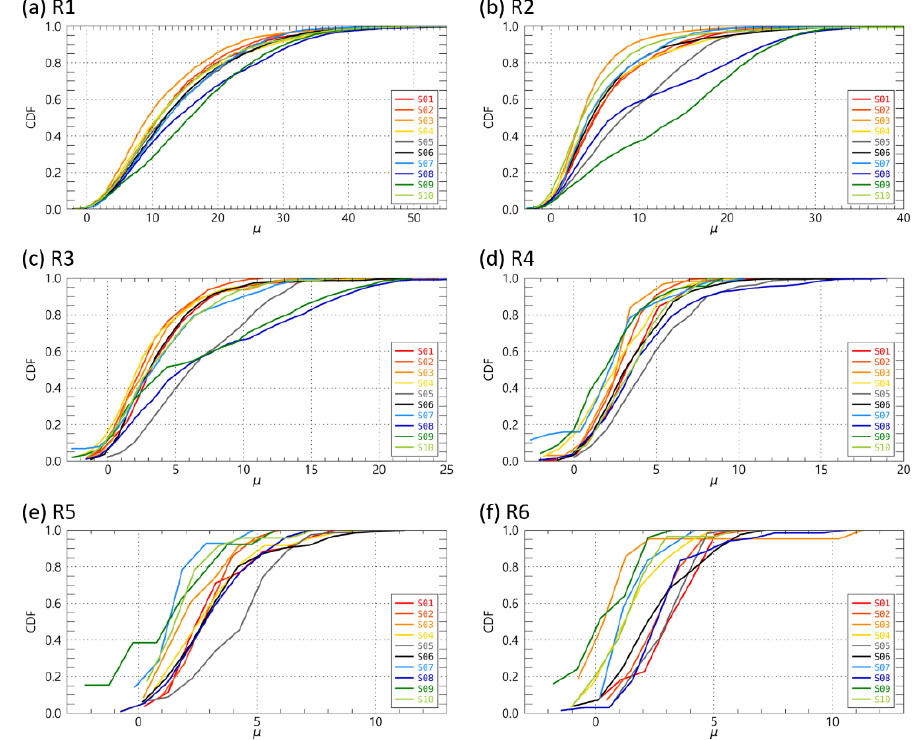
Figure 11. The cumulative distribution function of μ for rain rate categories at the 10 Parsivel sites.